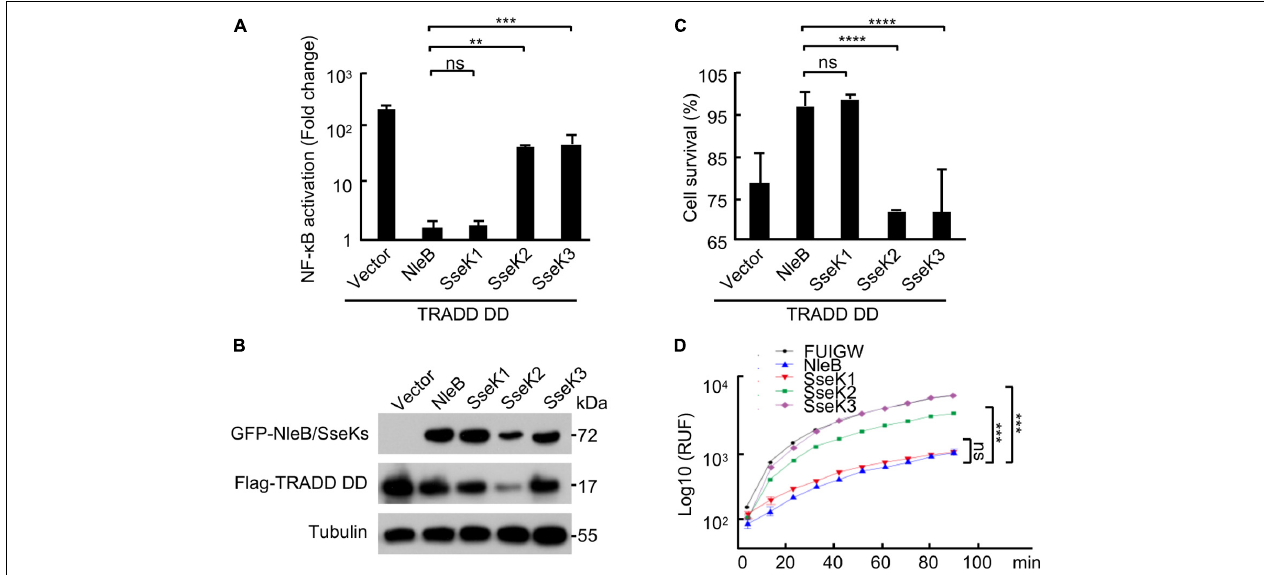
FIGURE 3 | SseK1 inhibits TRADD-activated NF- κ B and cell death signaling. (A–D) Effects of NleB/SseK on TRADD DD-activated NF- κ B (A,B) , cell survival (C) , and caspase-3 activation (D) . 293T cells were transfected with Flag-TRADD DD in combination with the indicated plasmids. NF- κ B luciferase activation was indicated as fold change (A) . Cell viability was determined by measuring ATP levels (C) . Caspase-3 activity was assayed using an Ac-DEVD-AFC probe according to manufacturer’s instructions (D) . For A and C, one-way ANOVA was used for statistical analysis. And for D, two-way ANOVA was used. ** P < 0.01, *** P < 0.001, **** P < 0.0001, ns, not statistically significant. All data are acquired at the same time and at least three independent experiments.